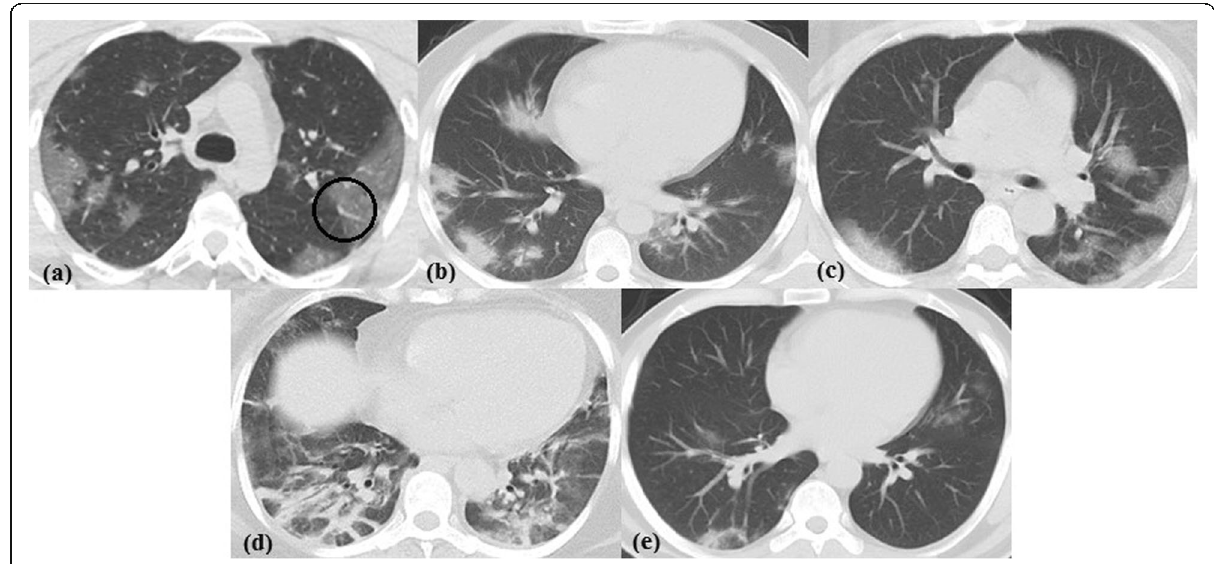
Fig. 3 Non-contrast CT chest axial cuts in lung window showing the main findings in RT-PCR proved COVID-19 cases. a Multifocal bilateral peripheral GGO in a 35-year-old male associated with vascular thickening (circle). b Multifocal bilateral peripheral consolidation in a 45-year-old male. c Multifocal bilateral peripheral and central crazy paving in a 55-year-old female. d Peri-lobular fibrosis in a 50-year-old female. e Right lower lung lobe posterior segment reversed halo sign in a 46-year-old